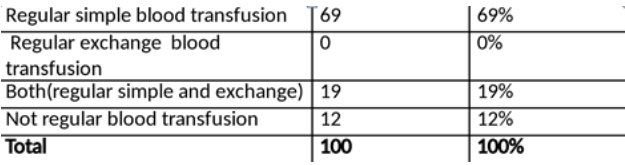
Table 1: frequency of Blood transfusion in the population studied